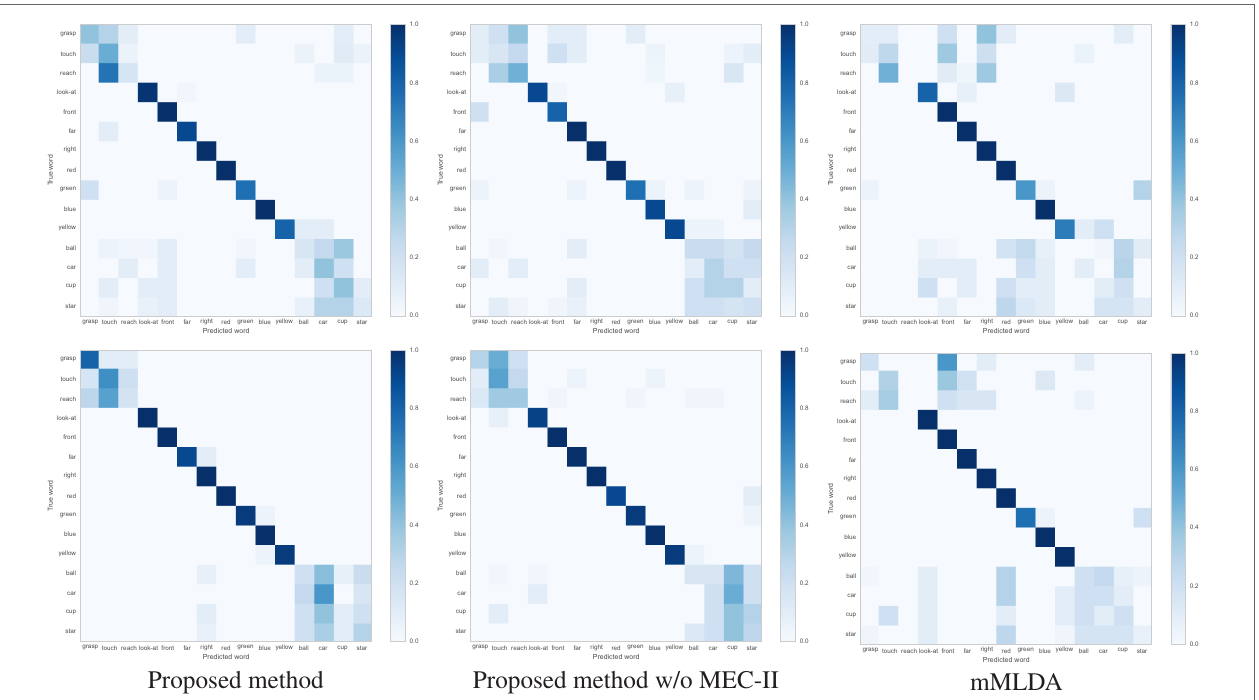
FIGURE 10 | Confusion matrix of results on action description task using the learning result by (top) 20 and (bottom) 40 trials under the ROW is 0%.